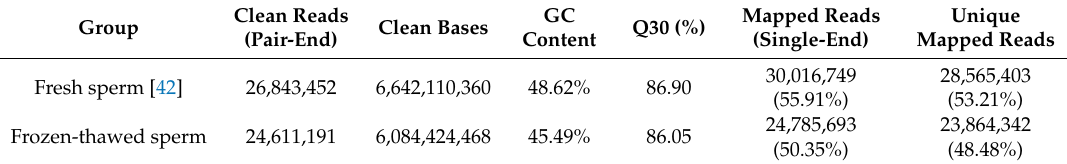
Table 2. Overview of transcriptome sequencing in fresh and frozen-thawed boar